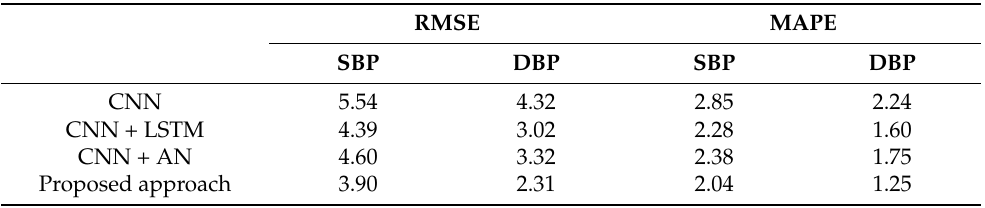
Table 4. Experimental results of different network structures.